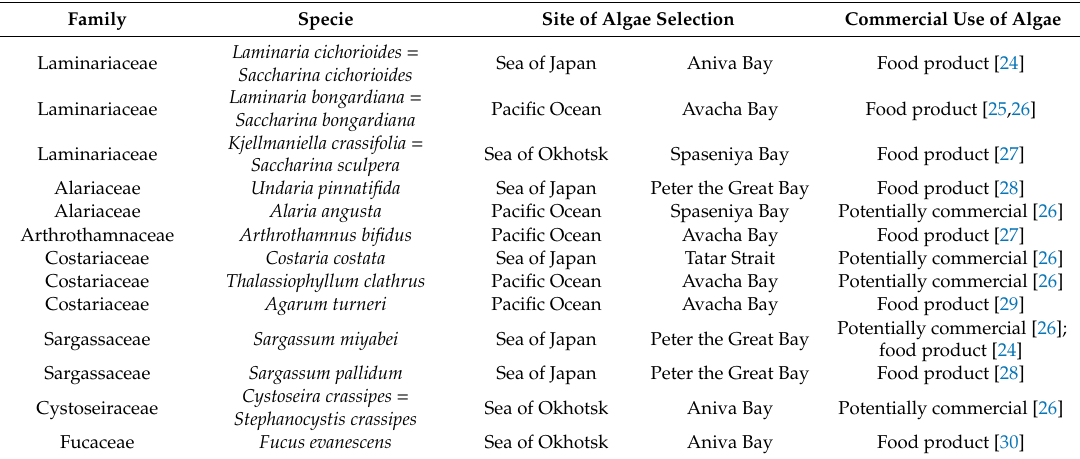
Table 1. Description of the algae and the area of their